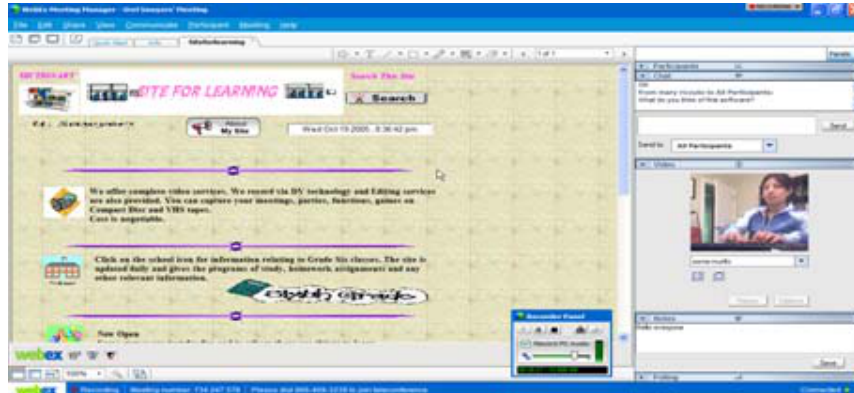
Figure 2. A WebEx meeting with browser